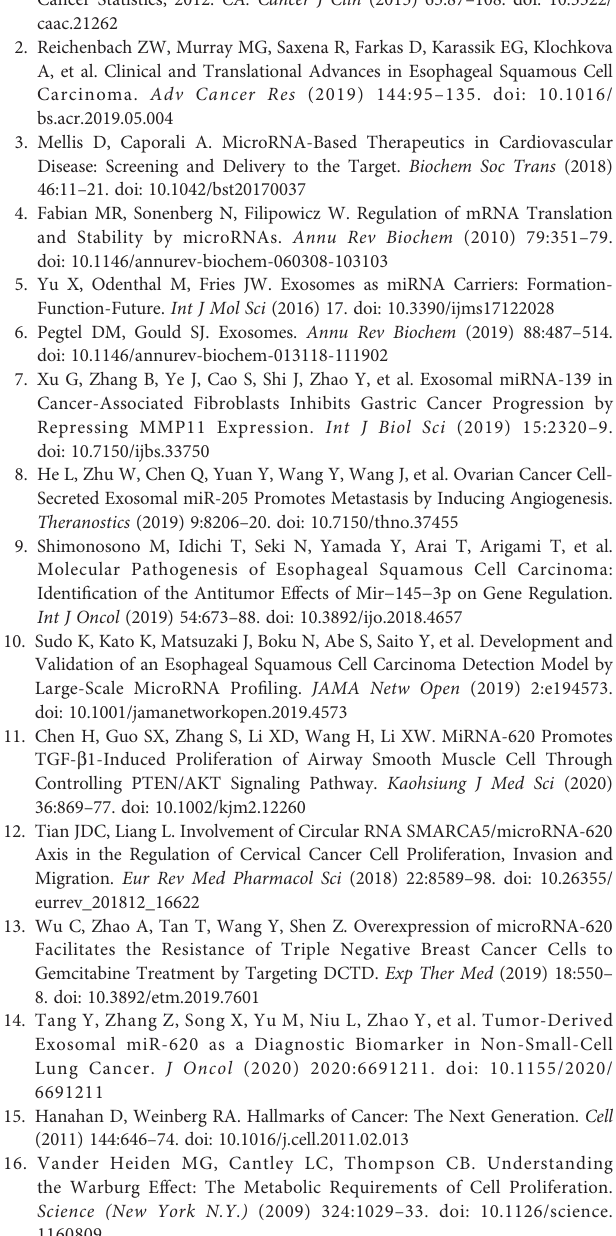
Supplementary Figure 4 | FOXM1regulatestheaerobicglycolysisofESCCcells throughHER2. (A) FOXM1expressionwasenhancedinESCCcellsbythetransfectionof pcDNA3.1-FOXM1. (B – E) .qRT-PCRwasutilizedtotesttheglucoseconsumption,total lactateprotein,relativePKcatalyticactivityandtheECAR/OCRratioinFOXM1- overexpressedESCCcells. (F – J) .HER2expressionwasenhancedinESCCcells,andthen qRT-PCRwasutilizedtotesttheglucoseconsumption,totallactateprotein,relativePK catalyticactivityandtheECAR/OCRratioinHER2-overexpressedESCCcells.**P<0.01.